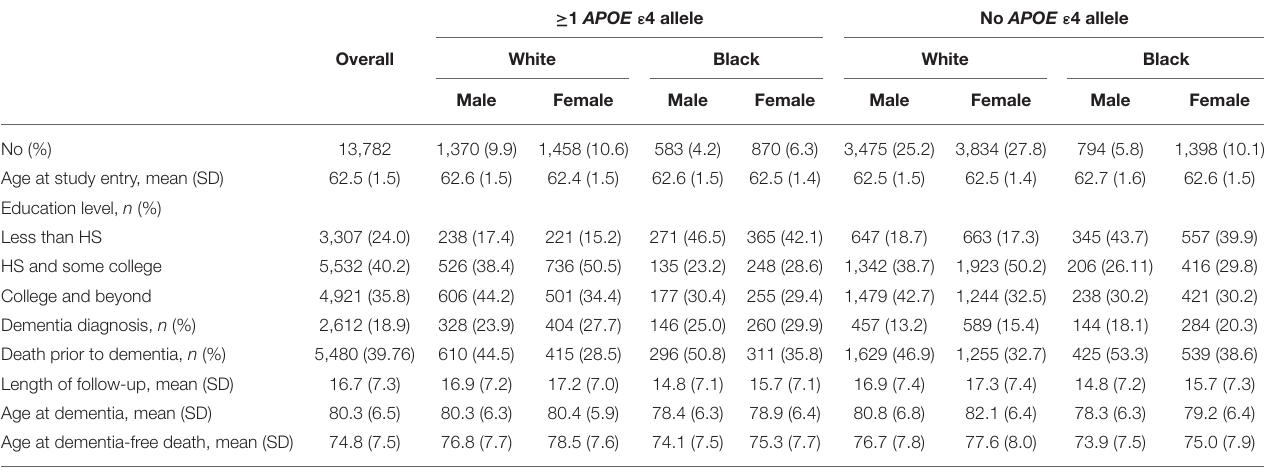
TABLE 2 | Median age (years) of dementia diagnosis or dementia-free death by APOE ε 4 s tatus in the ARIC cohort ( N = 13,782) a .